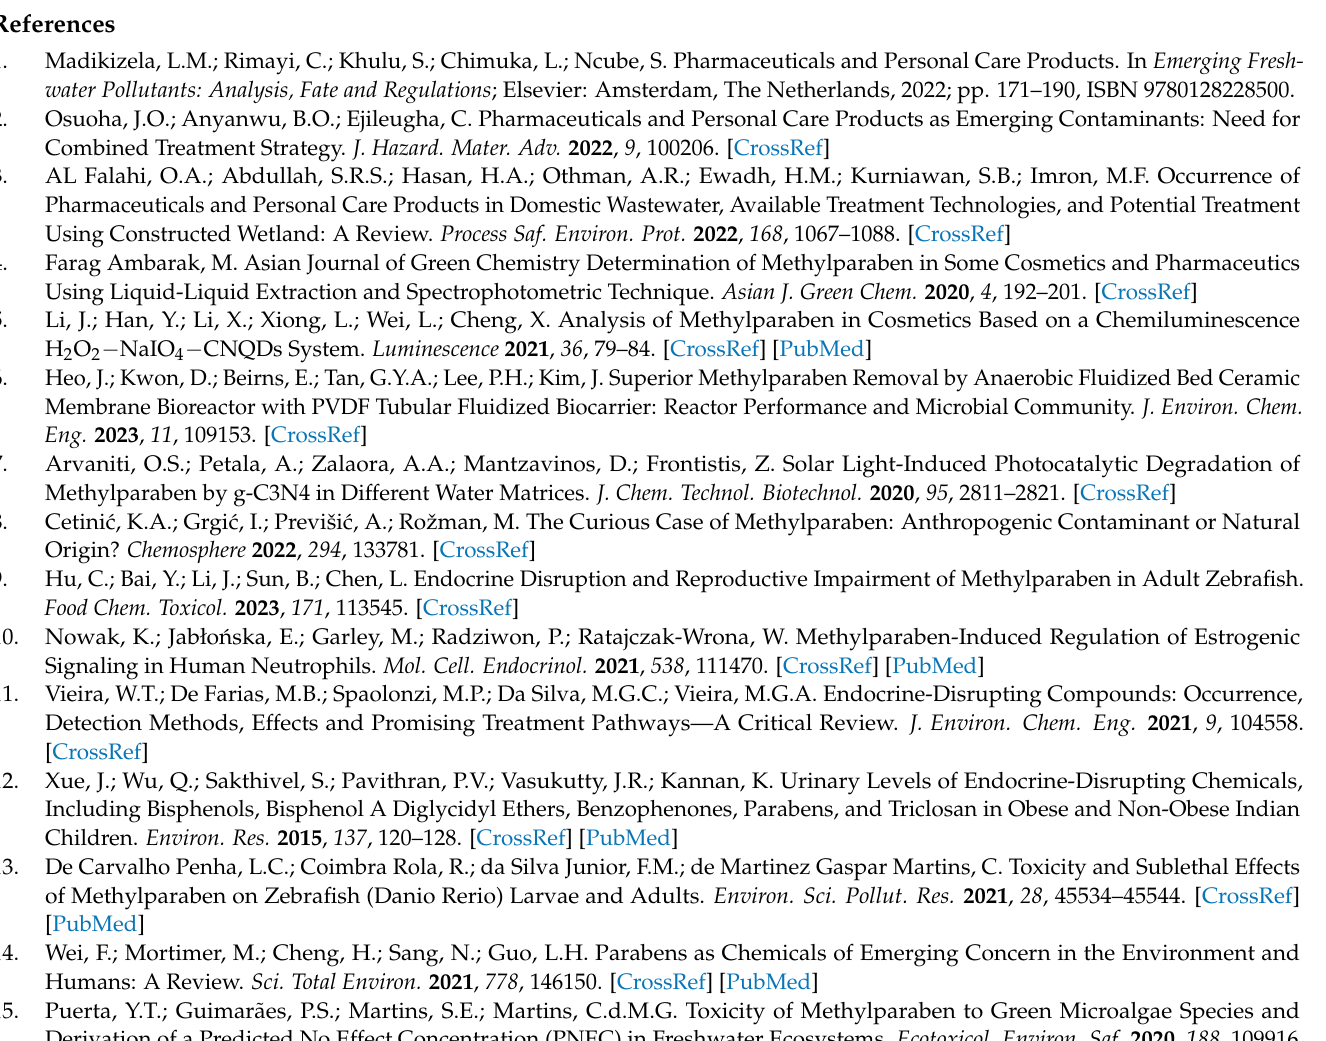
sanitizer, (B) mouthwash, (C) deodorant, D) emollient for cuticles and E) moisturizer cream samples; Figure S5: UV-vis spectra and respective quantification of MePa concentrations for (A) hand sanitizer, (B) mouthwash, (C) deodorant, (D) emollient for cuticles and (E) moisturizer cream